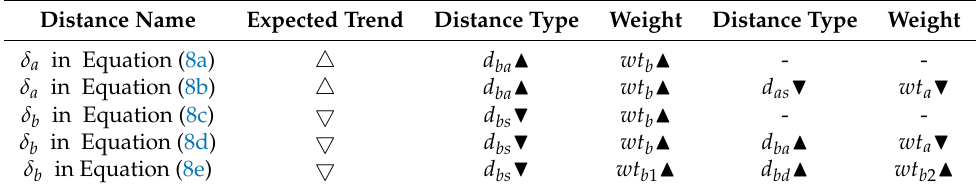
Table 1. The expected value and the relationship of distance, neighboring pixels and